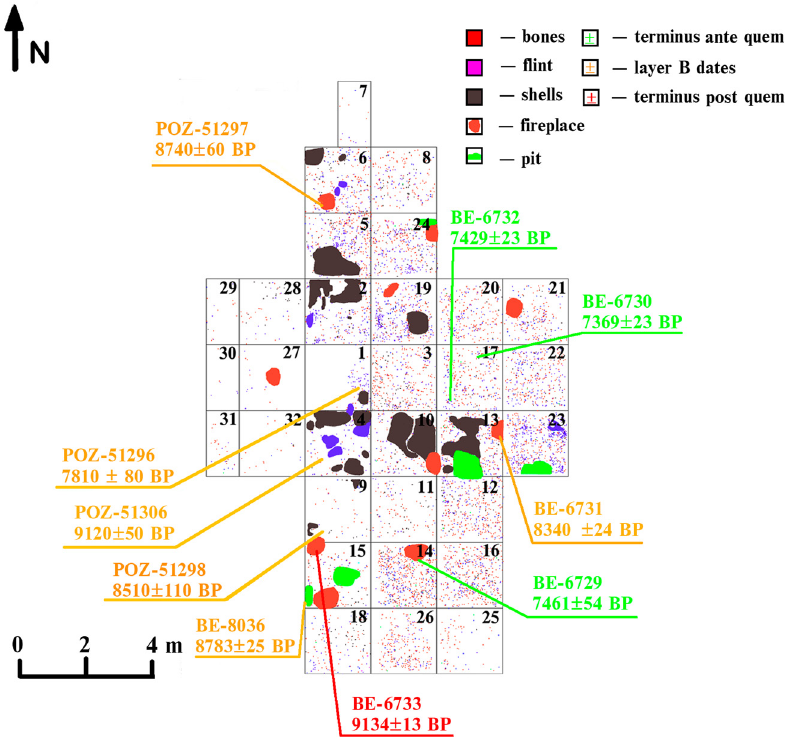
Figure 6: Plan of excavation trench 2 with indication of samples for radiocarbon